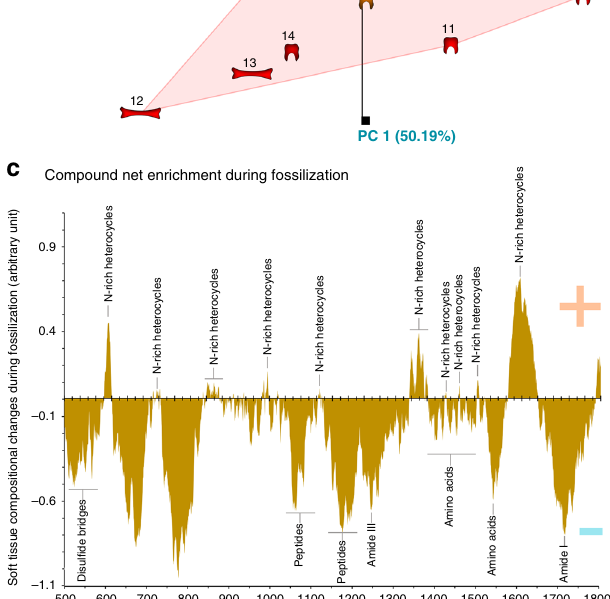
Methods Specimen samples . We investigated a total of 35 specimens (Figs. 2, 4, Supple- mentary Tables 1 – 4, Supplementary Figs. 1, 2, 3, 8, 9) — teeth and enamel scales ( n = 8), bones ( n = 10), and eggshells ( n = 6) — from reducing ( n = 9) and oxida- tive ( n = 8) depositional environments 37 , as well as glue ( n = 2), epoxy resin ( n = 1), and sediment samples ( n = 8).